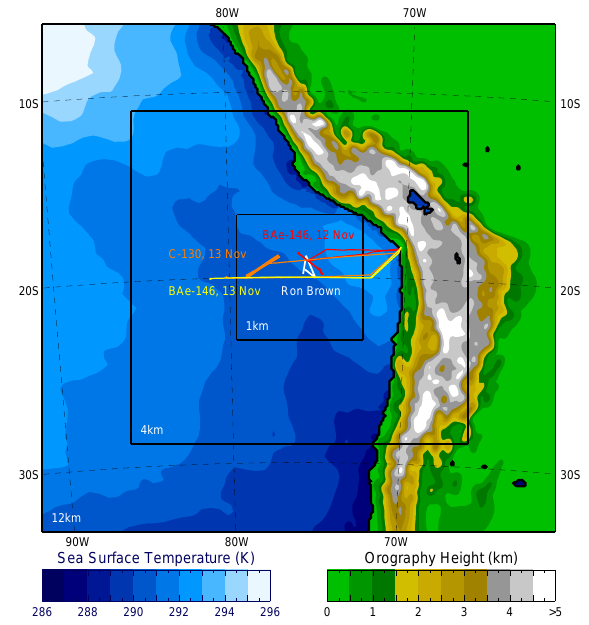
Fig. 1. Orography height and mean sea-surface temperature, with the horizontal coverage and resolution of the MetUM nested domains used in this study. Over-plotted are the tracks of the Ron Brown (white), BAe-146 (red and yellow) and C-130 (orange) during 12 and 13 November 2008.